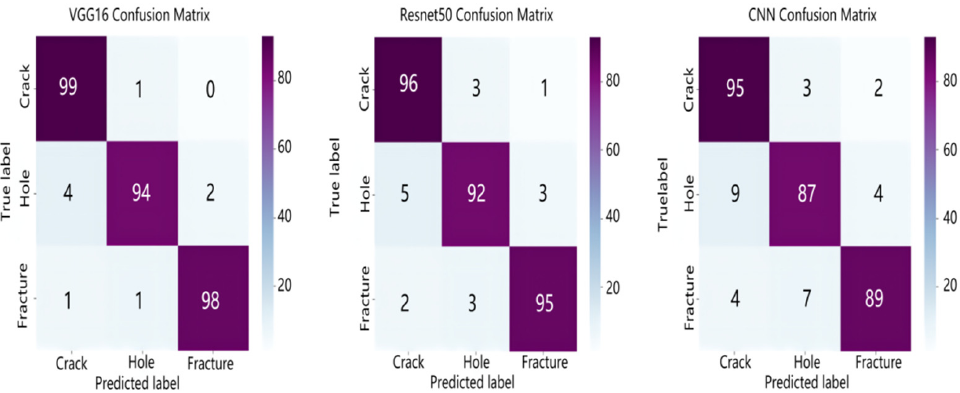
Figure 14. Comparison of three algorithms confusion matrix. Table 1. VGG16 defect classification results.